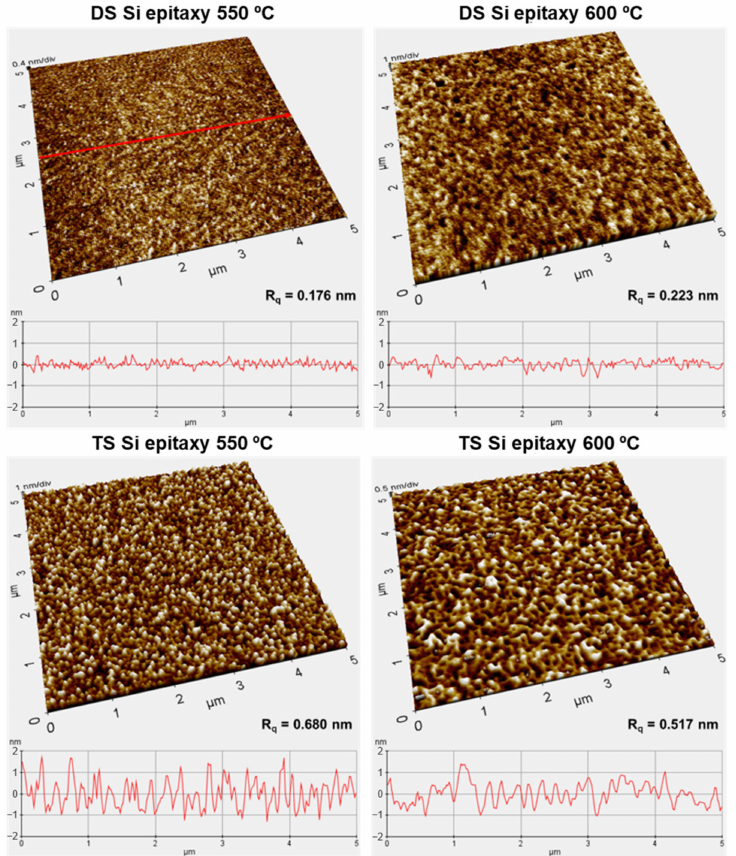
Figure 4. AFM measurements and RMS surface roughness (Rq) values of the Si epilayers grown under UHVCVD conditions at 550 and 600 ◦ C using disilane (DS) and trisilane (TS). The red lines represent the results of the line scans and their positions. All line scans were performed at the same